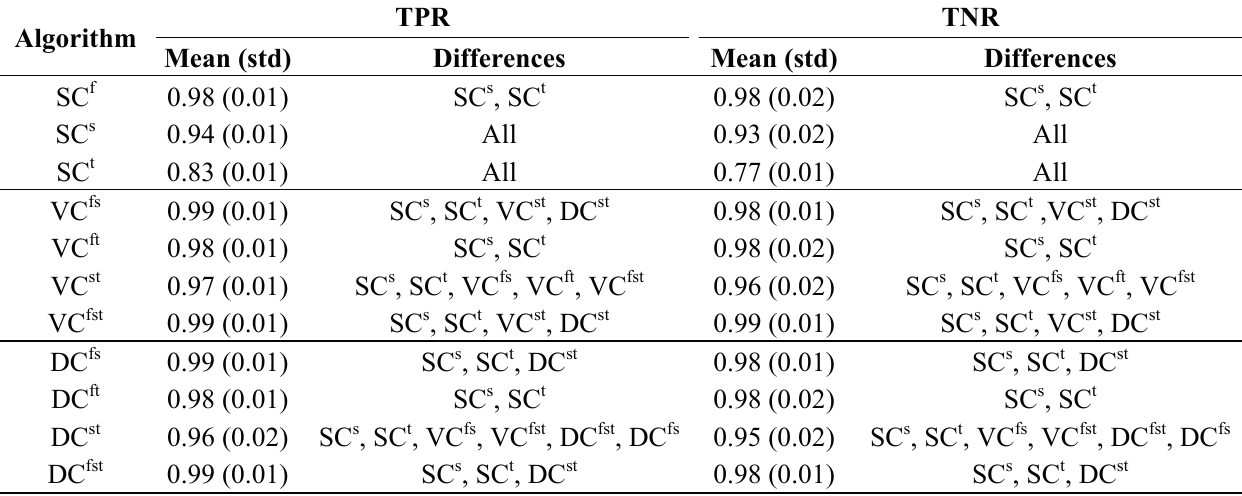
Table 1. Means, standard deviations of True Positive Rate ( TPR ) and True Negative Rate ( TNR ), and statistical differences for all combinations of Scalar Classifier (SC), Vectorial Classifier (VC), and Distributed Classifier (DC). “All” indicates statistically significant differences between the specific algorithm and the